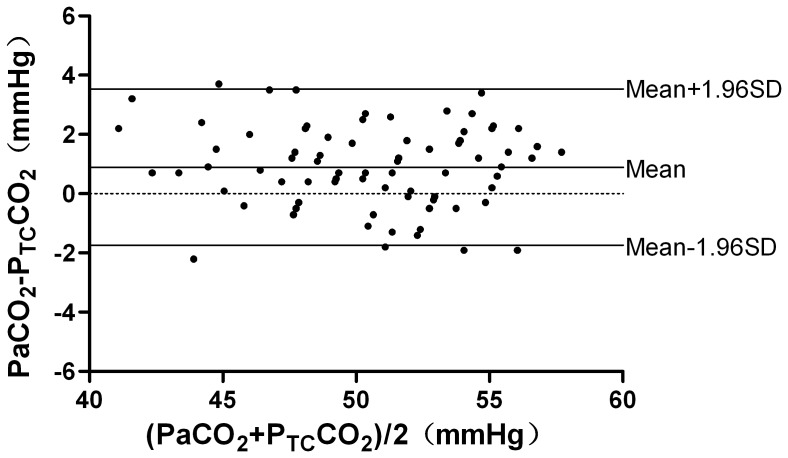
Agreement between PTCCO2 and PaCO2.Agreement between PTCCO2 and PaCO2 by the Bland-Altman method. Plot of the arterial carbon dioxide minus the transcutaneous carbon dioxide (y-axis) against the mean of the transcutaneous carbon dioxide and the arterial carbon dioxide (x-axis).The bias and precision are labeled. The 95% limits of agreement (LOA) of the average PaCO2–PTCCO2 difference was 0.9±2.6 mmHg (mean±1.96 SD).